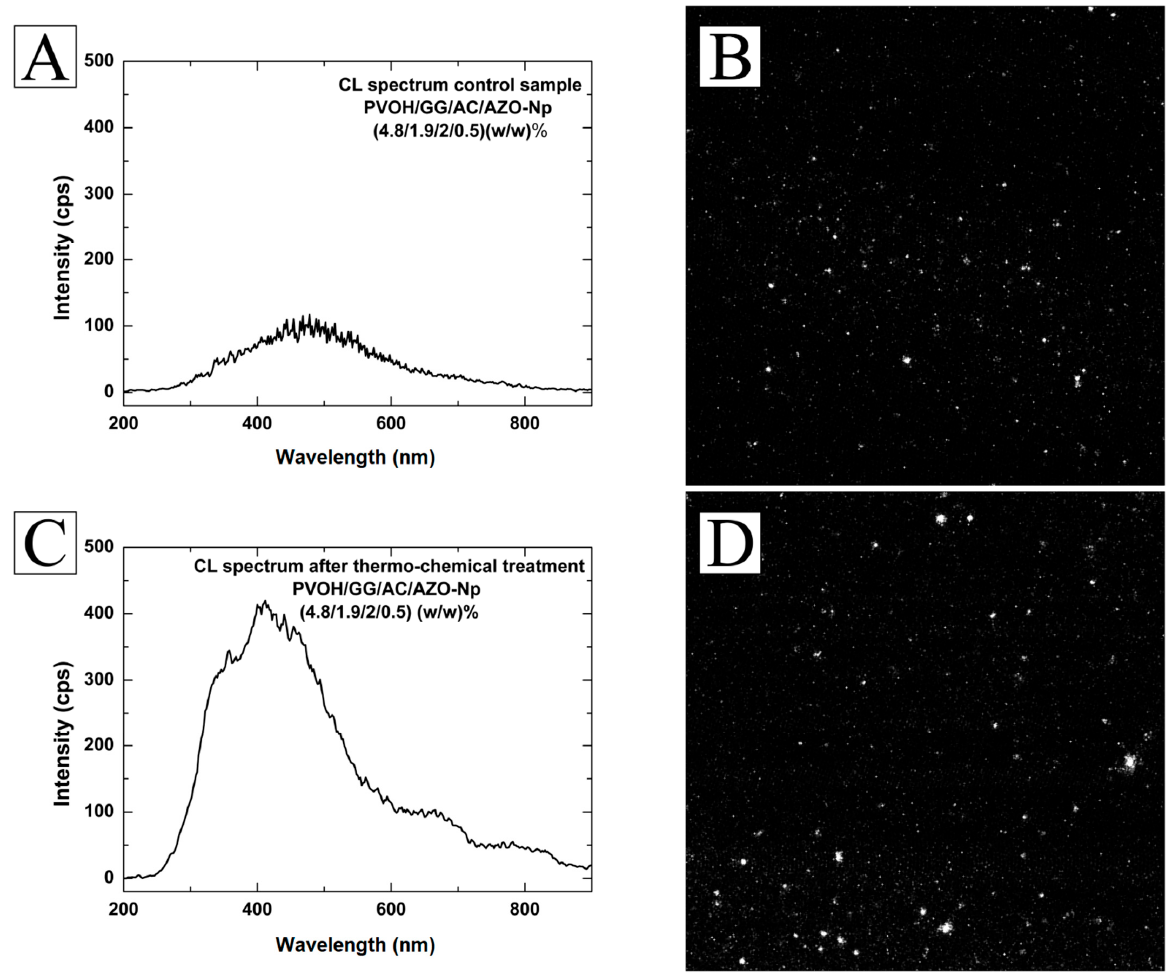
Figure 4. ( A ) CL spectrum obtained from a membrane with a three-fold increase in citric acid content. ( B ) CL image from the same membrane filtered at 380 nm, 200 × . ( C ) CL spectrum from the thermo- chemically treated membrane showing great change due to AZO-Np regrowth. ( D ) CL image from the thermo-chemically treated membrane filtered at 380 nm, 200 ×